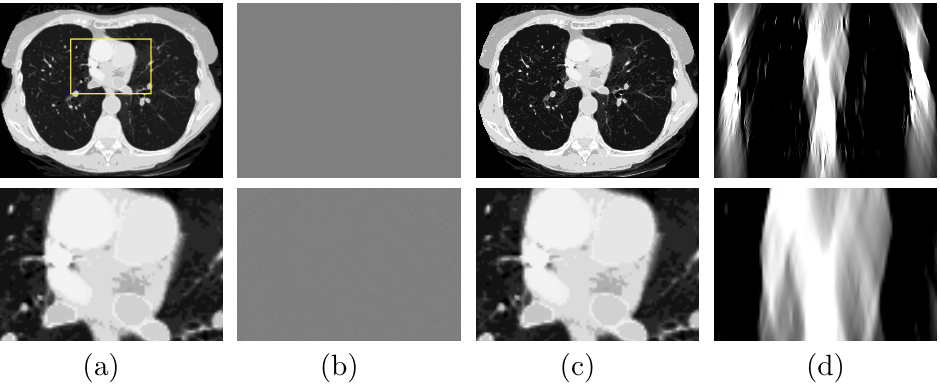
Figure 3. Row 1: ( a ) VMI of the chest phantom at 100 keV obtained with the two-step method from FAR data, ( b ) difference between the VMI in ( a ) and its truth in Figure 2c, and VMIs at 100 keV obtained with ( c ) the two-step method and ( d ) the FBP algorithm from noiseless data acquired over a SA of LAR 30 ◦ ; Row 2: zoomed-in views of their corresponding images in row 1. The zoomed-in area is enclosed by the rectangular box depicted in the VMI in ( a ). Display windows [0, 0.22] cm − 1 for columns ( a , c , d ), and [ − 10 − 4 ,10 − 4 ] cm − 1 for column ( b